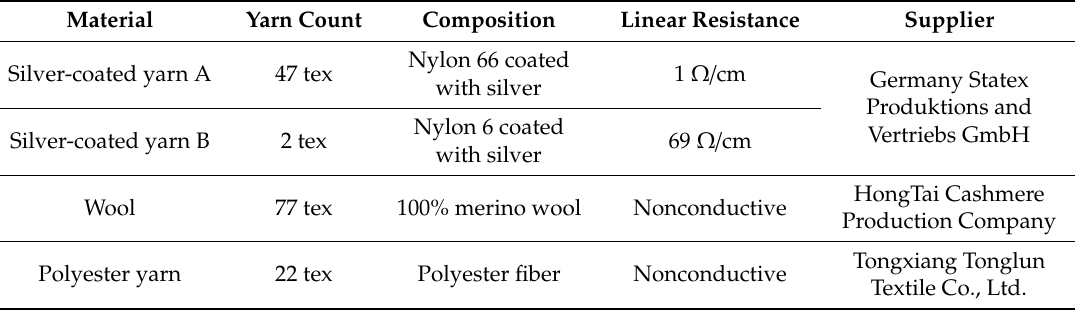
Figure 1. E-SEM micrographs of yarn B magnified 1000, 3000, and 5000 times from left to right (shot using a QUANTA environmental scanning electron microscope (FEI, Chech)). using a QUANTA environmental scanning electron microscope (FEI, Chech)). Table 1. Information on the specifications of the yarns in the Table 1. Information on the specifications of the yarns in the samples.